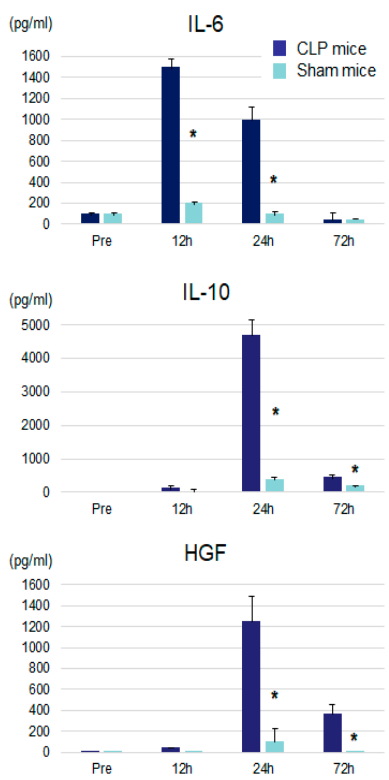
Figure 3. Serum IL-6, IL-10, and HGF levels after CLP or sham operation. IL: interleukin, HGF: hepatocyte growth factor, CLP: cecal ligation and puncture. * p < 0.05 vs. CLP mice.